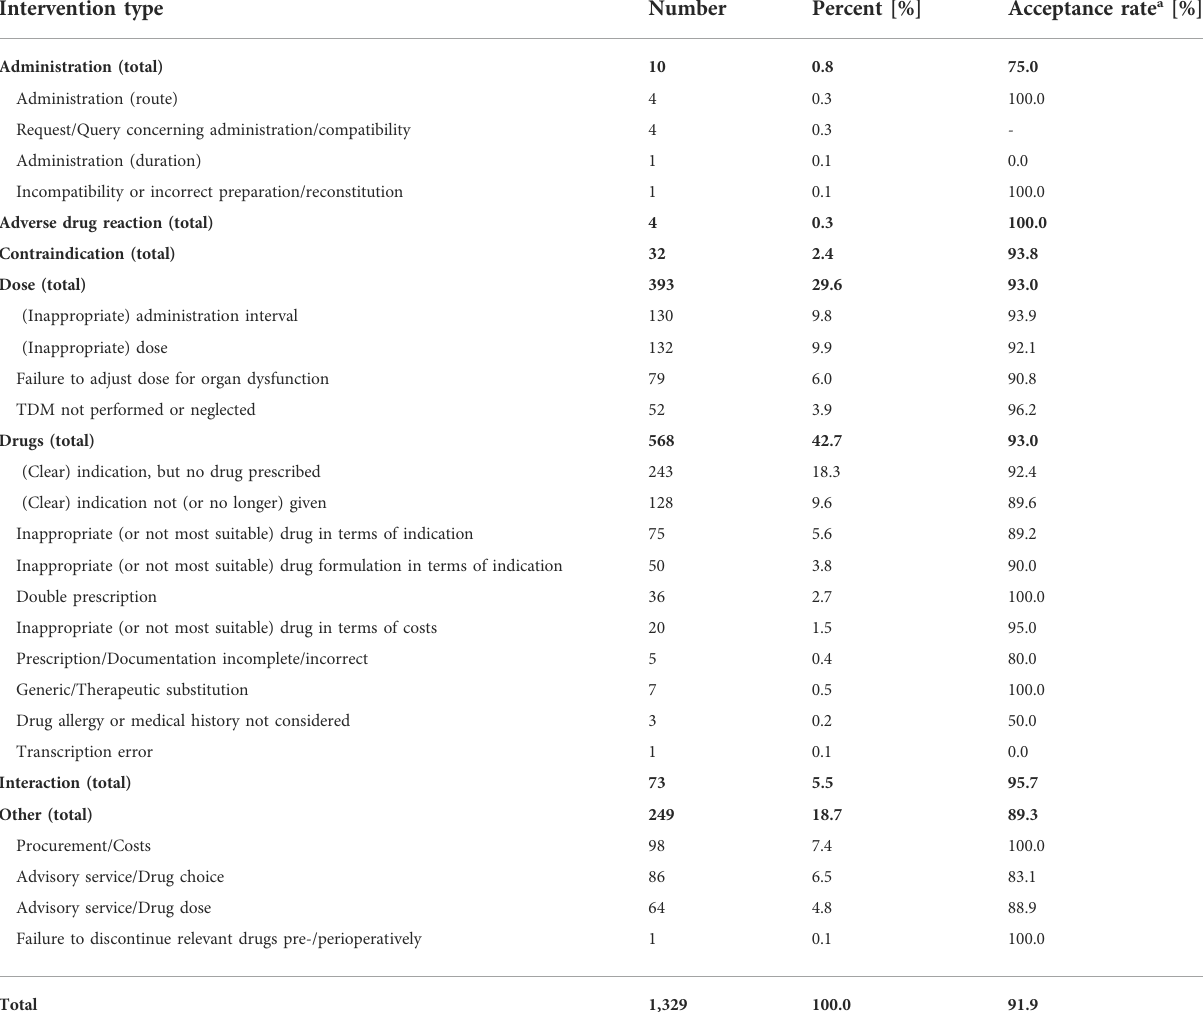
TABLE 2 Reasons for PIs and acceptance